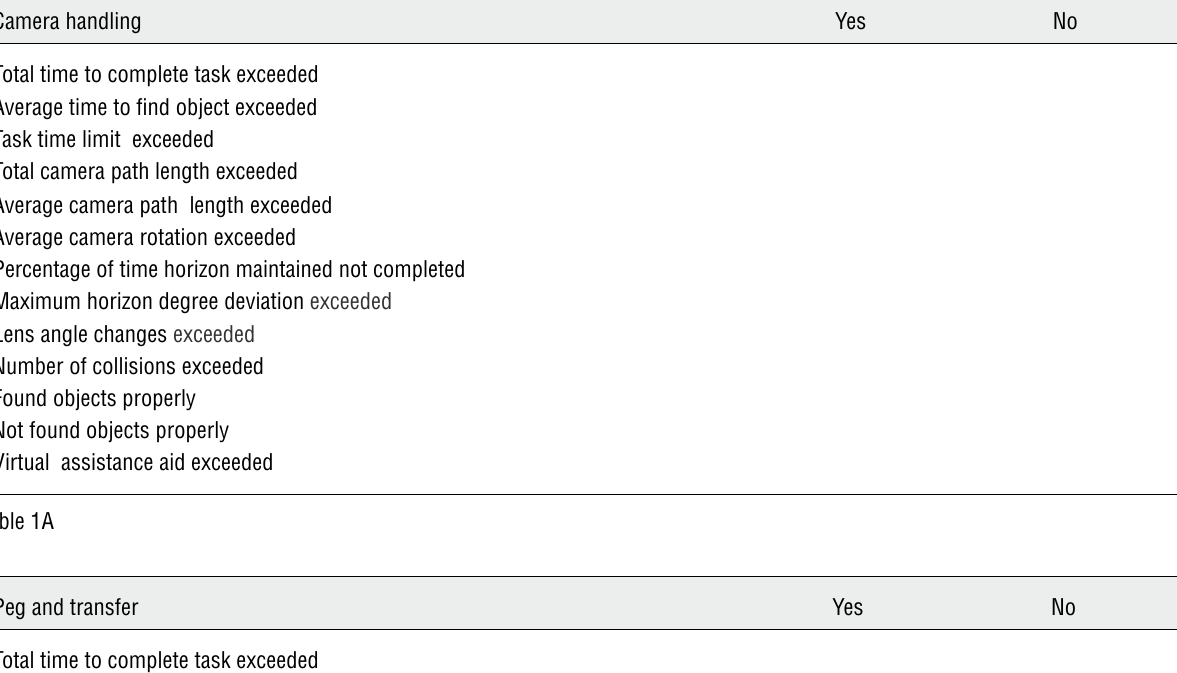
Table 1 (A.B.C.D) - List of basic procedures to be performed by the medical students: camera handling, peg and transfer, cutting and clipping. These procedures are in the simulator